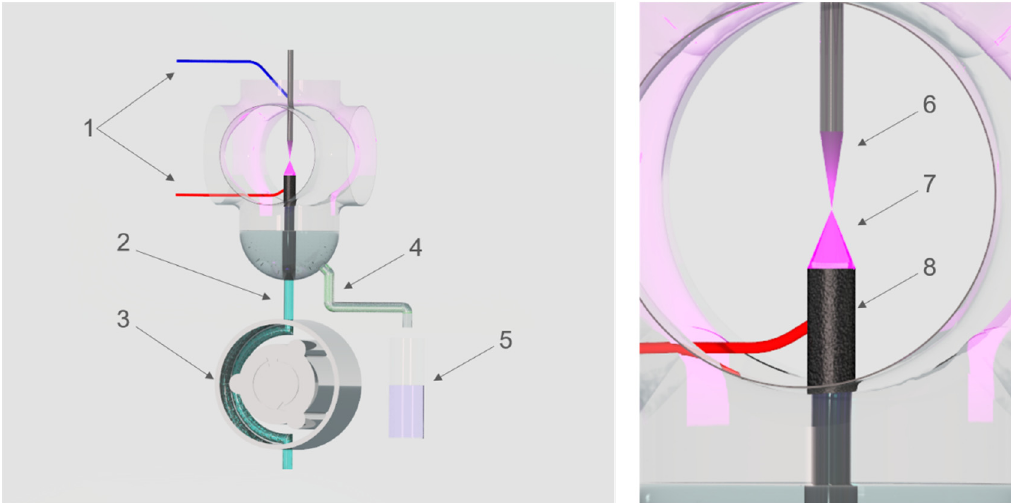
Figure 1. The plant extracts activation by direct current atmospheric pressure glow discharge (dc-APGD) operated in two modes (FLA-dc-APGD or FLC-dc-APGD). ( 1 ) high-voltage connections; ( 2 ) untreated plant extract inlet acting as a FLA or a FLC; ( 3 ) peristaltic pump; ( 4 ) collector of the activated plant extract; ( 5 ) container with an AuNPs precursor solution; ( 6 ) tungsten electrode; ( 7 ) FLA-dc-APGD or FLC-dc-APGD; ( 8 ) graphite tube covering a quartz